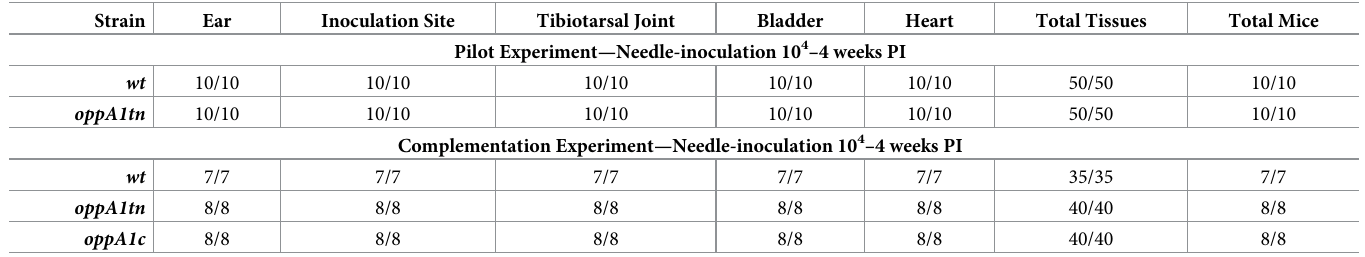
oppA1tn did not display a virulence defect (S2A Fig and Table 1 - Pilot Experiment). Two weeks after syringe-inoculation, spirochete burdens in ticks were assessed by semi-solid plat- ing of replete larvae fed on the infected mice. In stark contrast to larvae fed on wt -infected mice, larvae fed on oppA1tn -infected mice contained no live spirochetes (S2B Fig). Mutant spi- rochetes also were not recovered by plating from flat nymphs after the larvae had molted (S2C Fig). These experiments were repeated with the oppA1c strain and, as expected, the mutant and complement were comparably infectious in mice (Table 1 –Complementation Experi- ment). Once again, there was no recovery of viable oppA1tn spirochetes from replete larvae, while complementation restored their ability to survive the larval blood meal (Fig 2A). Midguts